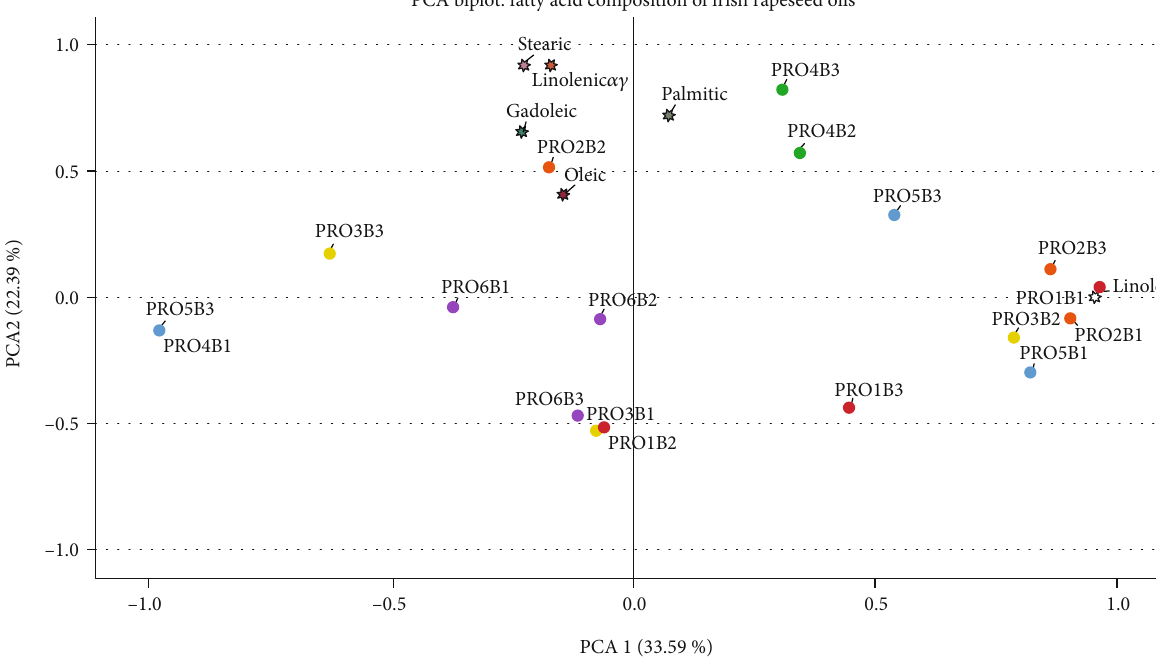
Figure 4: Principle Component Analysis (PCA) biplot of the fatty acid composition of rapeseed oil batches ( n = 3 ) with individual fatty acids identi fi ed. PCA1 accounted for 33.59% of the variance observed in the Irish rapeseed oil batches ’ fatty acid pro fi le, while PCA2 accounted for 22.39% of these variances. PRO1: red; PRO2: orange; PRO3: yellow; PRO4: green; PRO5: blue; PRO6: